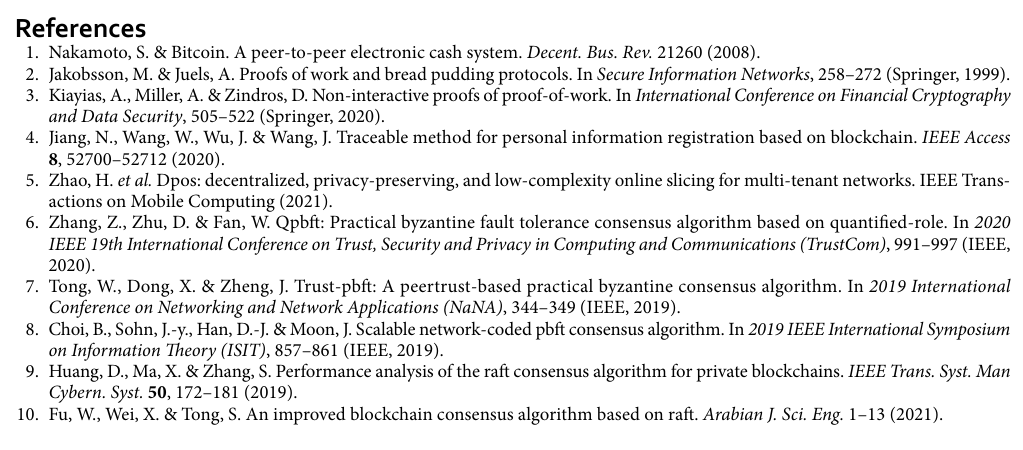
(11) TPS = Transactions � t /� t